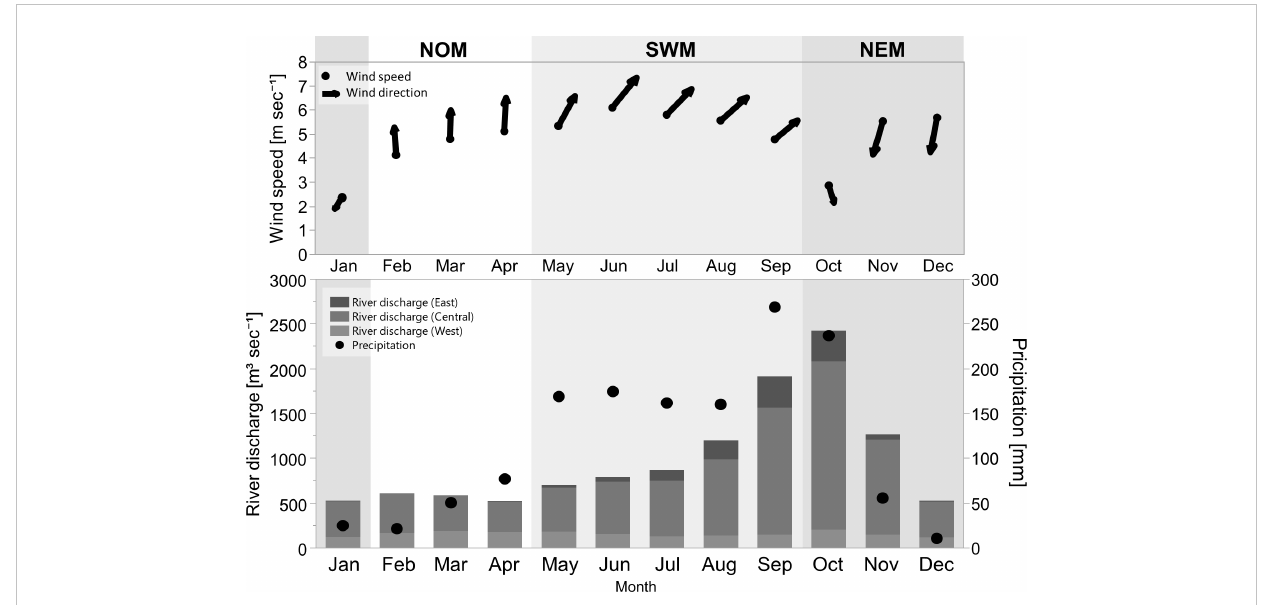
FIGURE 8 Monthly climatological data of sea surface wind speed and direction (upper), precipitation, and river discharge from the east, central, and west coasts of the uGoT (bottom) during 2003 – 2017; modi fi ed from Luang-on et al.